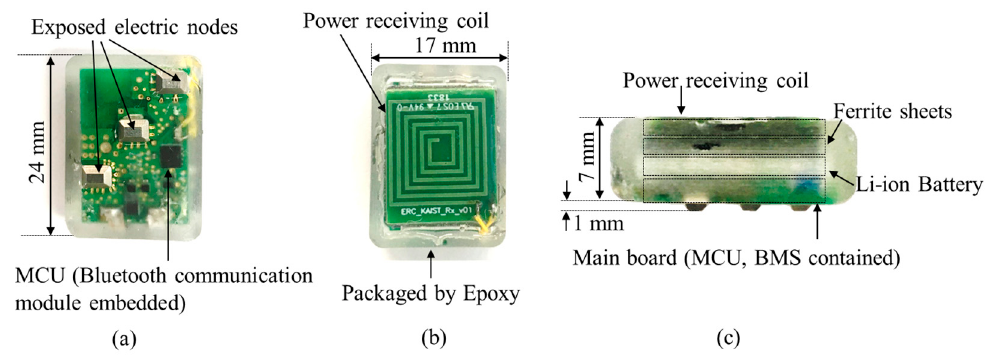
Figure 14. Photographs of the fabricated cardiac monitoring system. The outermost size was 17 mm × 24 mm × 8 mm. ( a ) Bottom view of fabricated ICM module. ( b ) Top view of ICM module. The ICM module is covered by Epoxy. ( c ) Side view of ICM module. Ferrite sheets added to enhance the magnetic coupling.